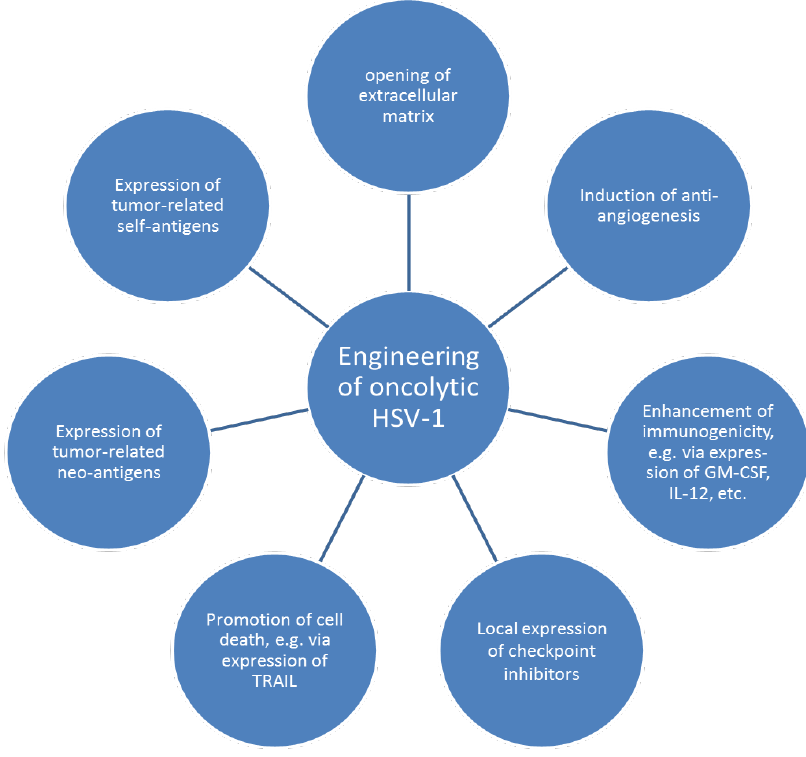
Figure 2. Prospects of optimizing anti-tumor activities via genetic engineering of oncolytic herpes simplex viruses 1 (HSV-1). HSV-1 can be designed to express proteins which modify the tumor environment, e.g., via restricting blood supply of the tumor, reducing barriers for efficient viral spread, enhancing influx of immune cells through production of pro-inflammatory cytokines, and/or contributing to local increase of immune cell activity. Engineered HSV-1 may also promote tumor cell lysis via expression of apoptosis-inducing ligands or stimulate different cells of the adaptive immune system as vaccine vector presenting neo- or self-antigens. Adapted according to [86].